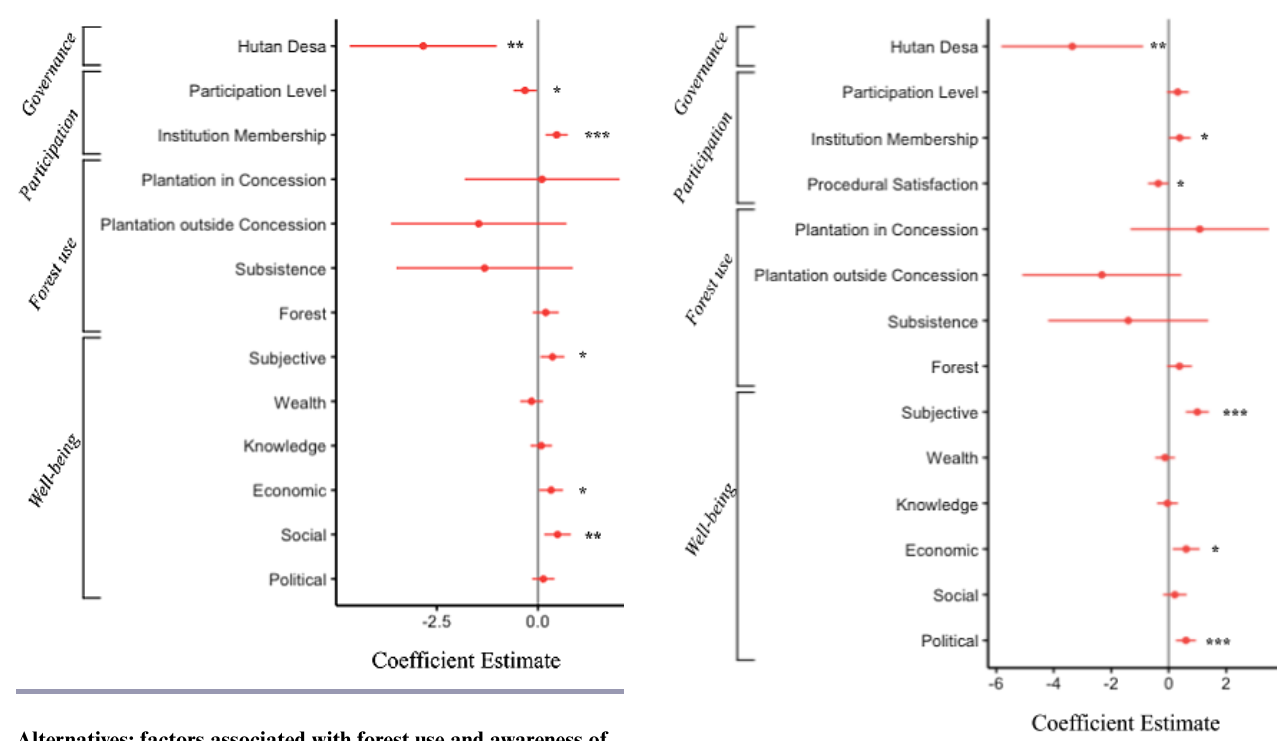
Fig. 6 . Coefficient estimates from cumulative link mixed model with conservation support level as the response